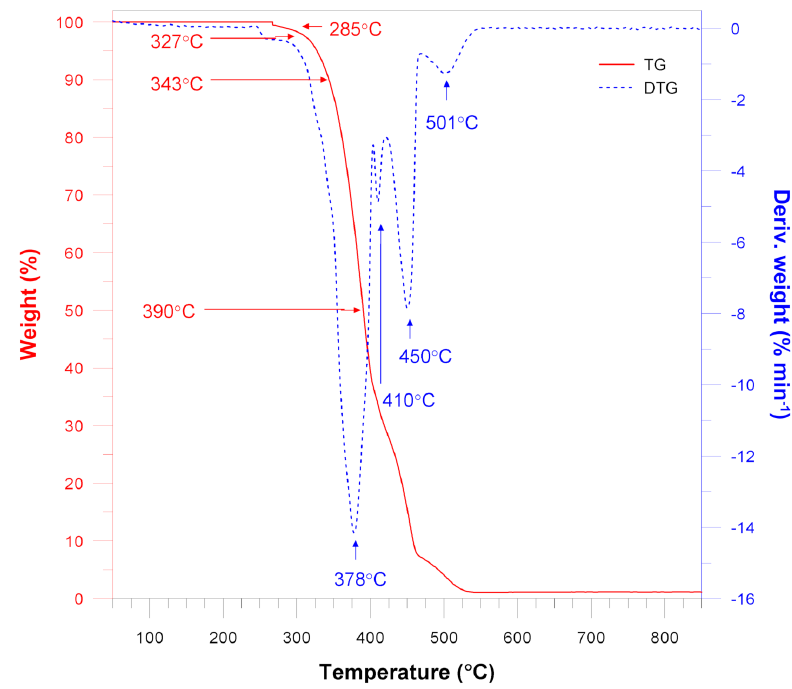
Figure 10. Thermal decomposition of the pure